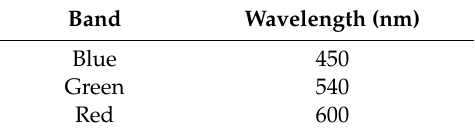
Table 1. Canon EOS 400 and 450D sensor wavelengths. Band maxima for red, green, and